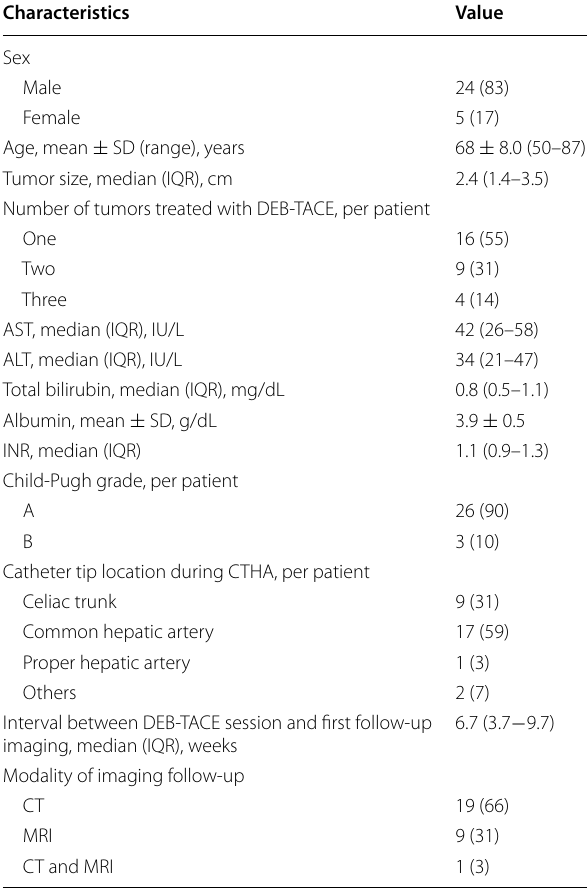
Table 1 Baseline demographics and clinical characteristics of 29